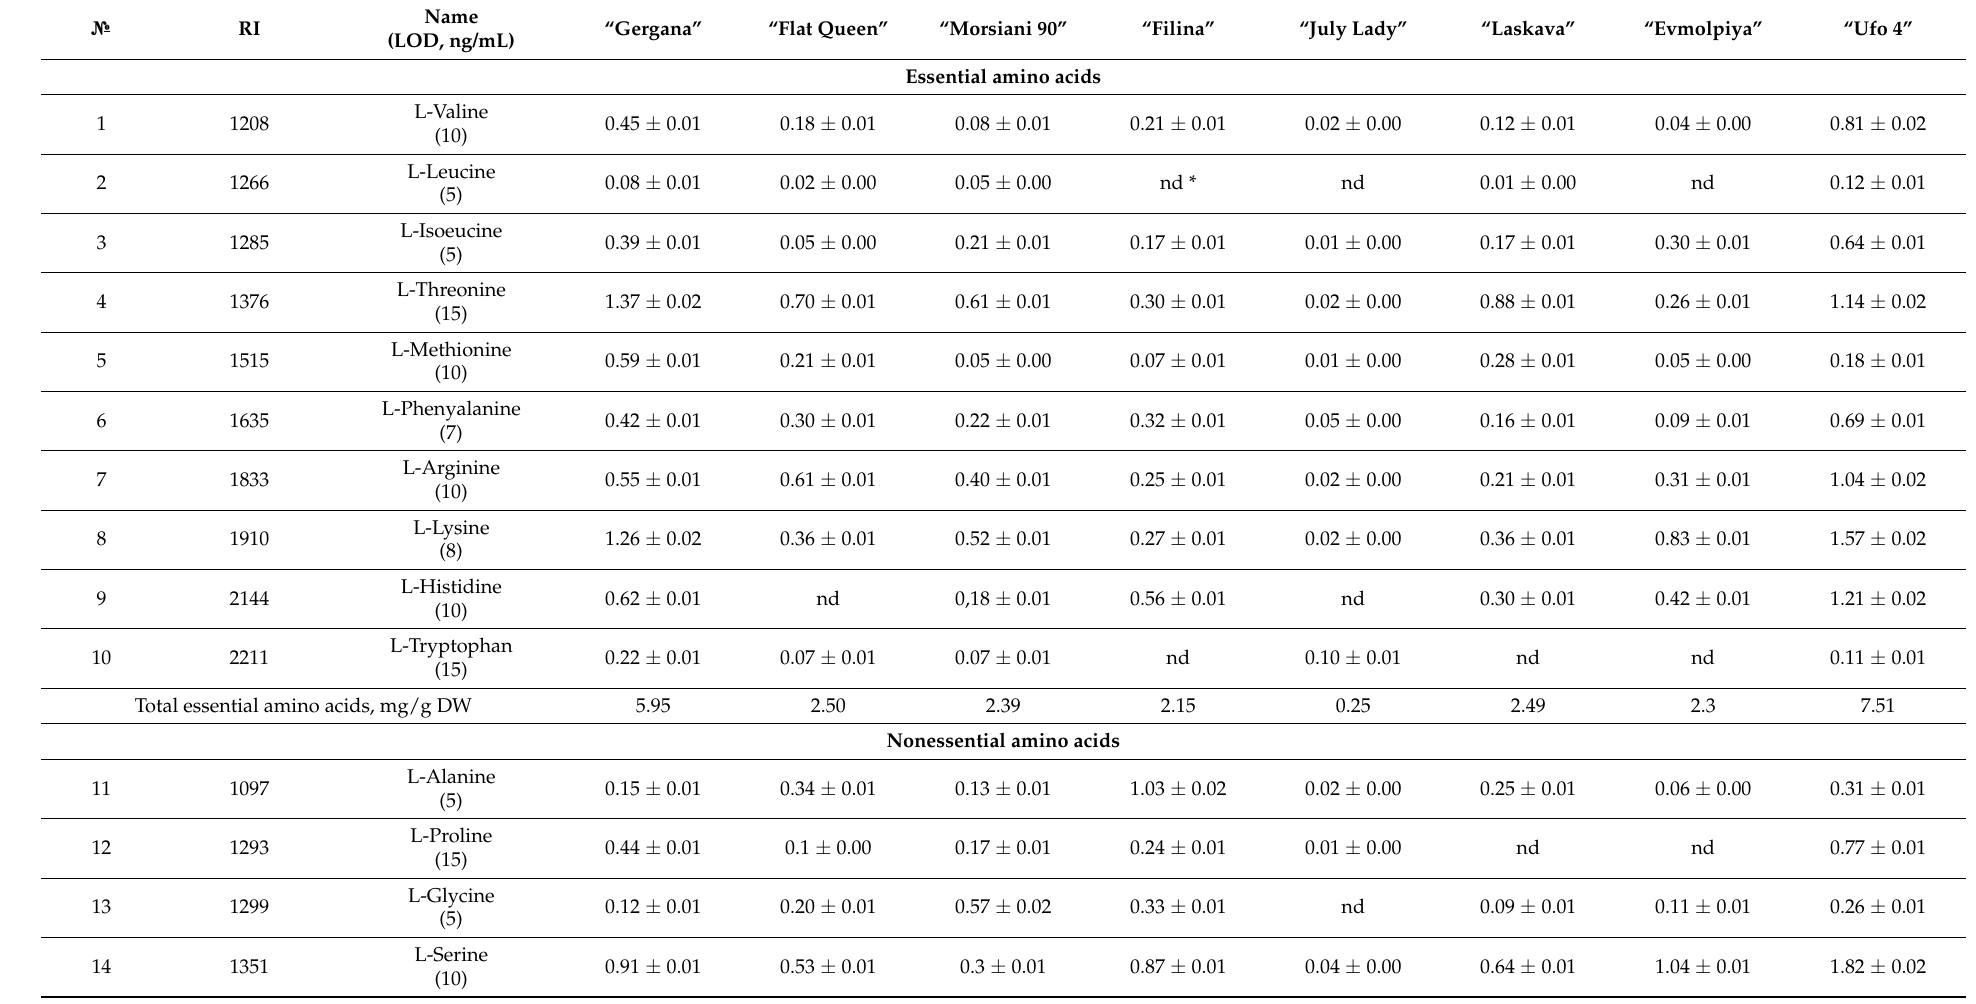
Table 1. Metabolites identified (mg/g DW) in polar fraction I of peach ( Prunus persica L.)